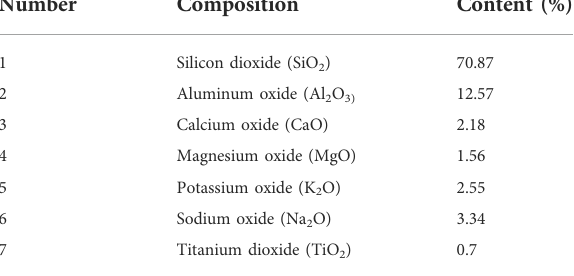
TABLE 3 Composition and content of fi